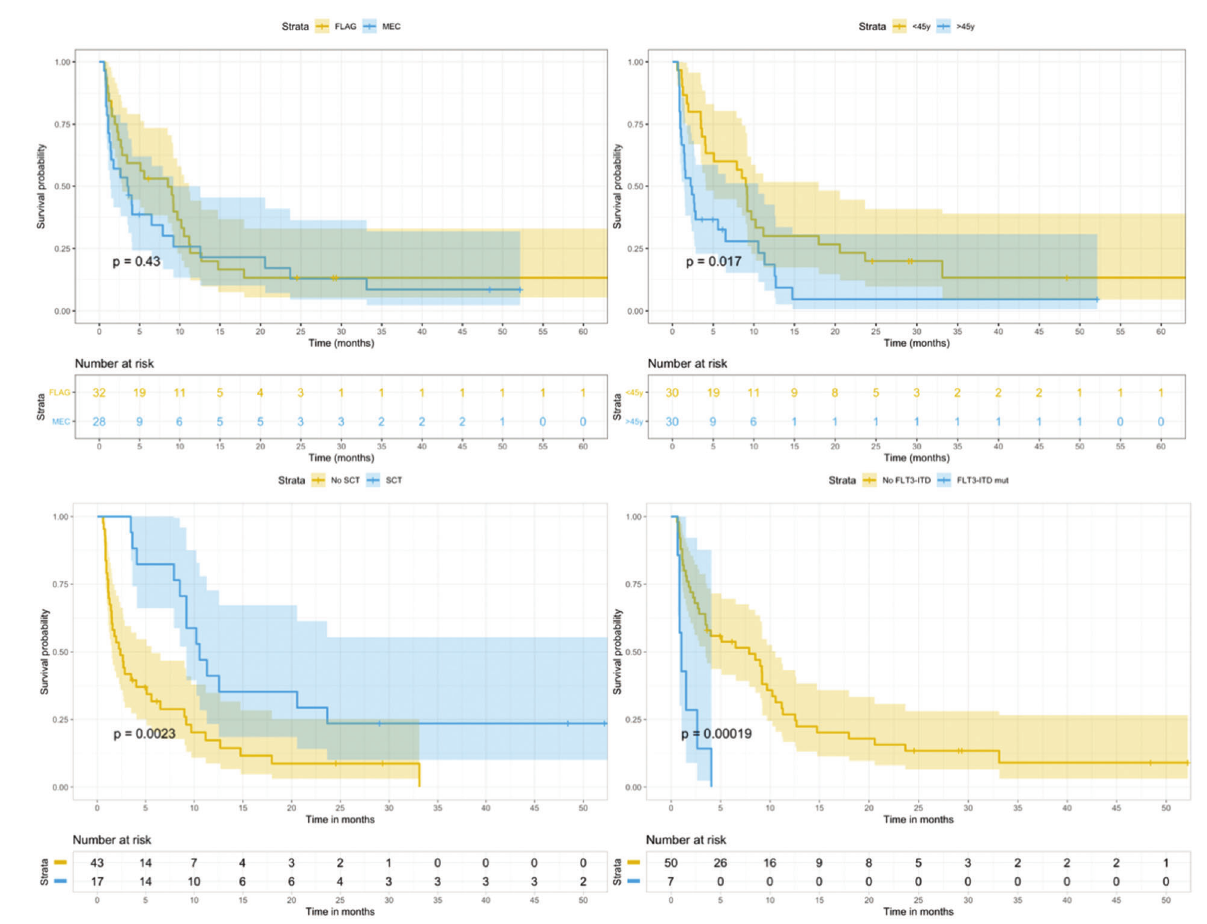
Figure 2 - Comparison of overall survival curves according to regimens (top left), age (top right), SCT execution (bottom left), and FLT3 status (bottom